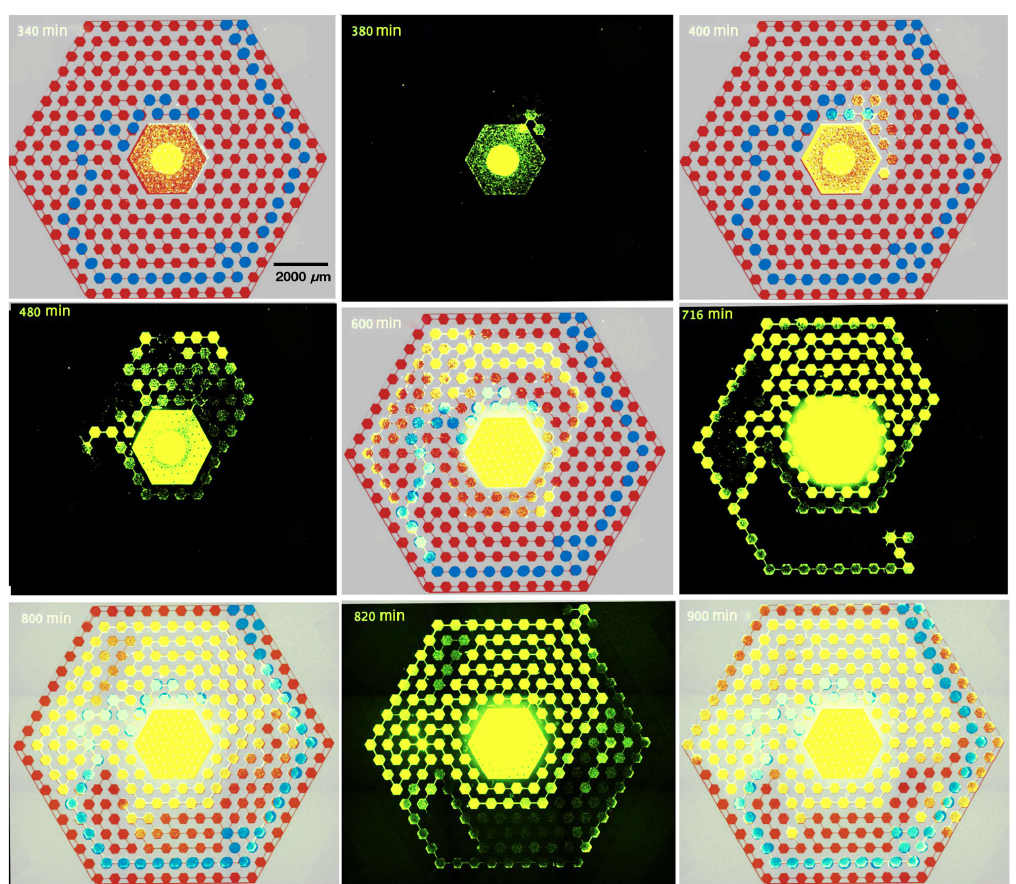
FIG. 3. Stitched images of bacteria entering a maze with a net collective inward flow at selected times. We have superposed the maze as red hexagons, the shortest path is shown with blue hexagons, in every other time